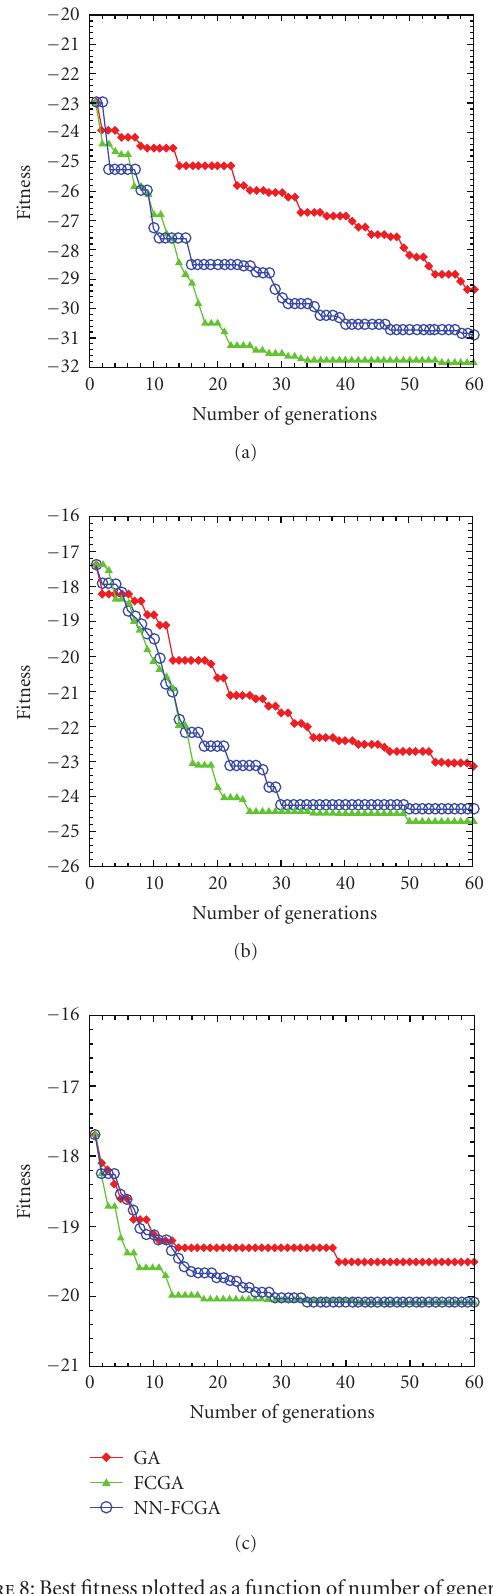
Figure 8: Best fitness plotted as a function of number of generations for (a) the TM polarization, (b) TE polarization, and (c) TM + TE polarization absorber designs, respectively. In these cases, GA, FCGA, and NN-FCGA are all performed for